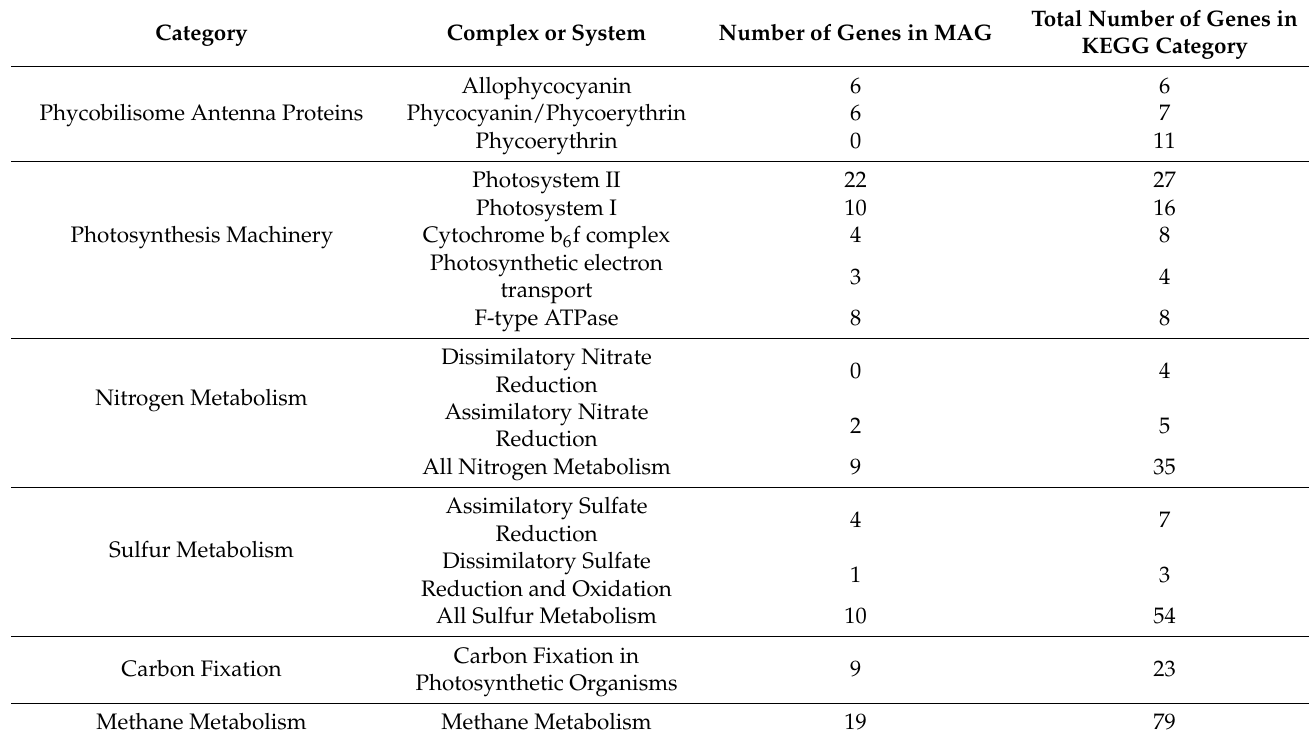
Table 5. Number of genes present in the P. pseudopriestleyi MAG in functional categories based on KEGG annotations. A full list of these genes is available in supplemental